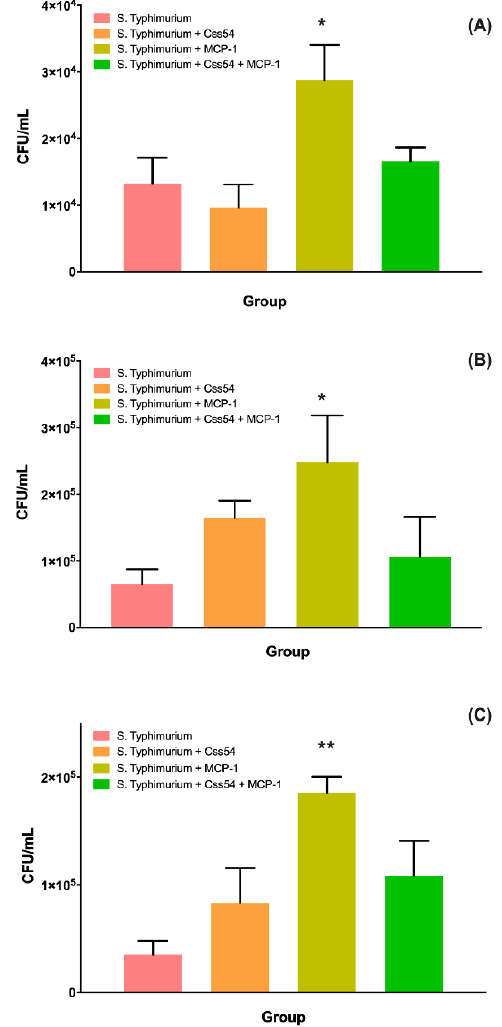
Figure 8. Css54 and MCP-1 did not decrease the bacterial load. Bacterial count in ( A ) peritoneum; ( B ) liver, and ( C ) spleen. Balb/C mice were infected with S. Typhimurium (≈ 4 × 10 6 CFU) and treated with Css54, MCP-1, and Css54 + MCP-1 Css54 (15 µ M) after 24 h of infection. After receiving the treatment, the status of the mice was monitored, and after 24 h, they were sacrificed to perform the bacterial count. The bacterial count was performed in the peritoneum at 72 h ( n = 6). This figure shows the average and standard deviation of six individuals from two independent experiments (* p < 0.05; ** p < 0.01).